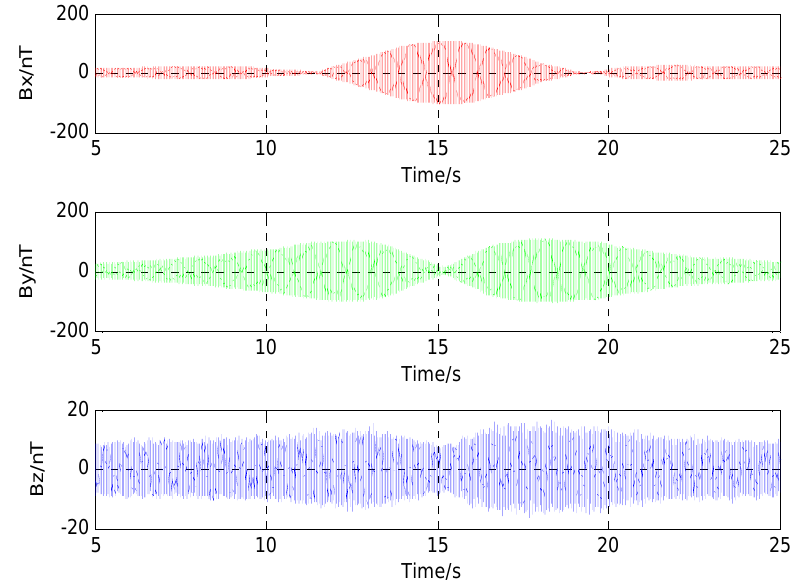
Figure 12. Alternating magnetic field data processed through a high-pass filter.